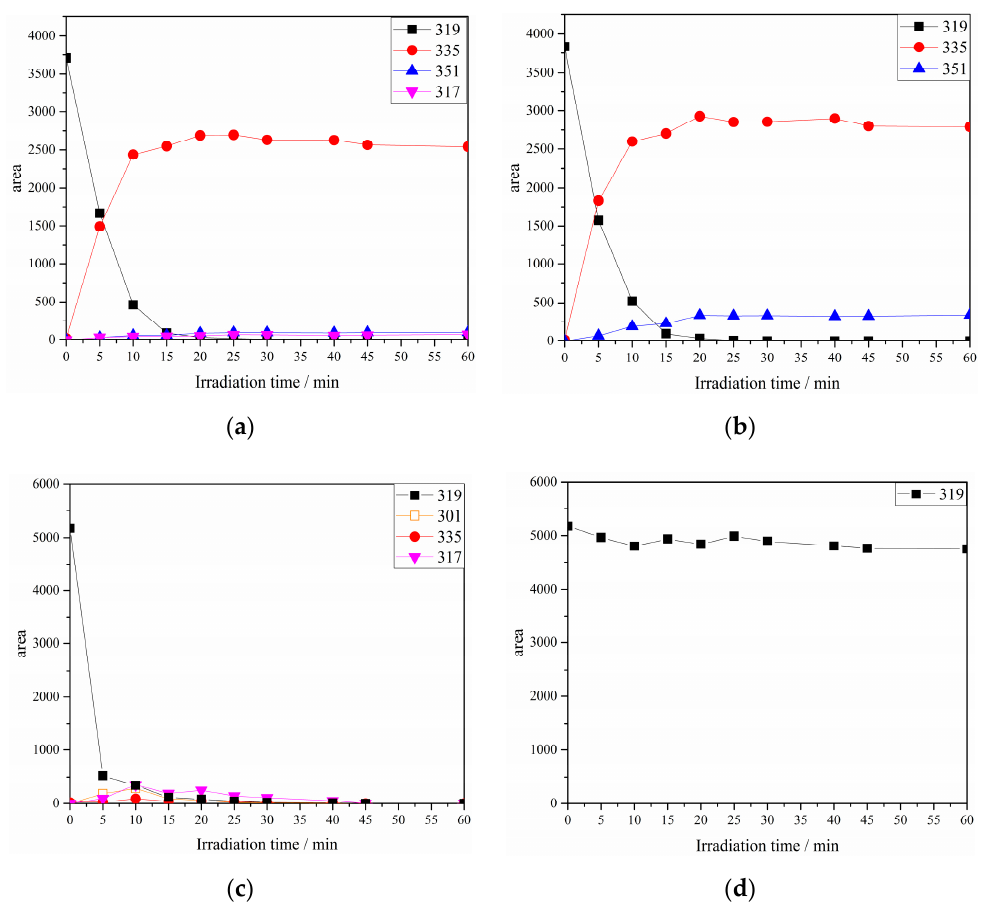
Figure 3. Time course of the intermediates formation during chlorpromazine conversion: ( a ) photocatalysis upon UV(A) irradiation, ( b ) photocatalysis upon visible light irradiation (K-7000 as photocatalyst (1 g L − 1 )), ( c ) photolysis upon UV(A) irradiation, and ( d ) photolysis upon visible light irradiation.